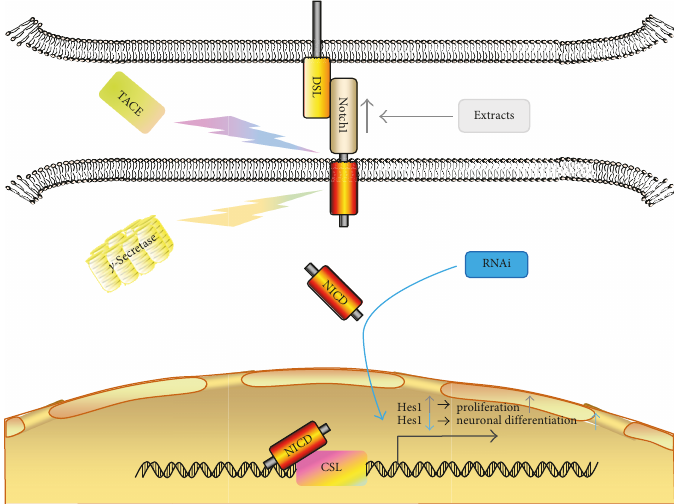
Figure 2: The upregulation and downregulation of Hes1 in the Notch signaling pathway. After the TBI in mice, the RNAi downregulated the expression of Hes1 , and the NSCs in the DG di ff erentiated into neurons heavily (the blue arrows). The extracts from the injured spinal cord upregulated the expression of Notch1 and Hes1 , activated the Notch signaling pathway, and promoted the proliferation of NSCs (the gray